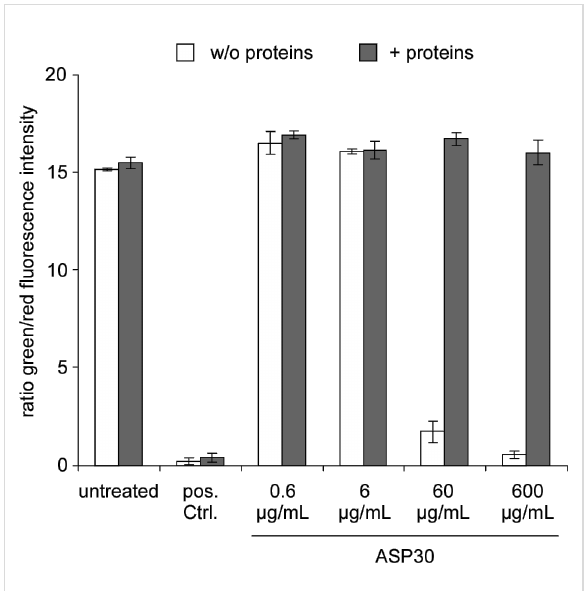
Figure 5: Quantification of the impact of ASP30 on the cell viability. Determination of the ratio of the average calcein (living cells; green) to ethidium homodimer-1 (dead cells; red) signals according to Figure 4. As described in Figure 4, CaCo-2 cells were exposed to the nanoparti- cles suspended in DMEM (open rectangles) or DMEM containing 10% human plasma (filled rectangles) for 4 h and analyzed by automated microscopy. Columns, mean; bars, ± SD from three independent